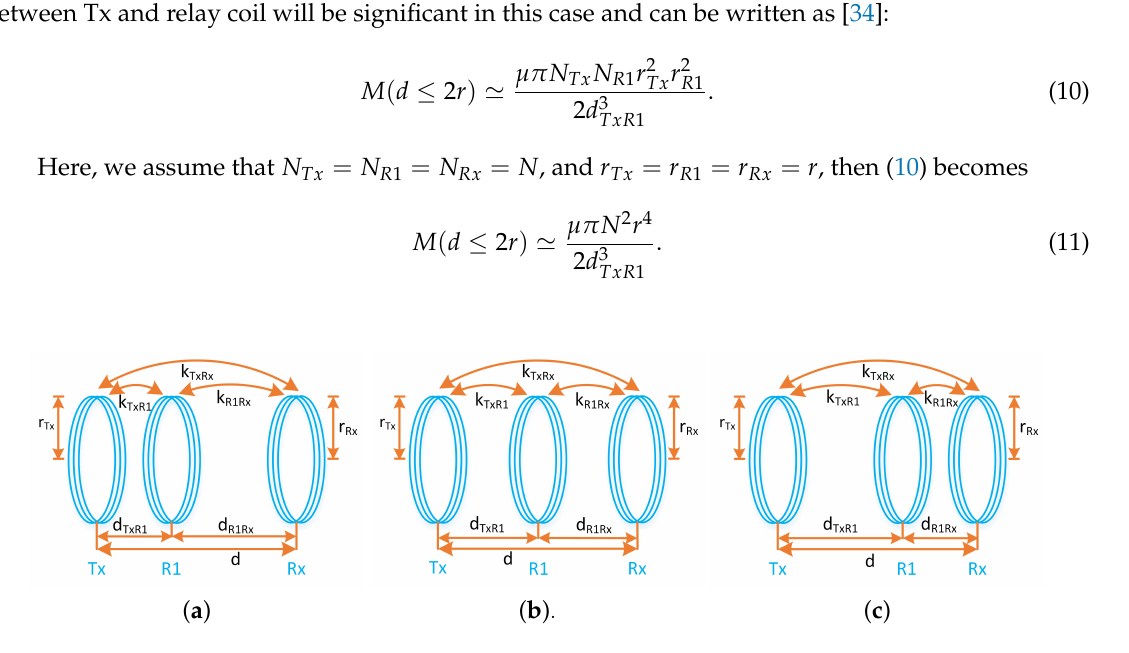
Figure 3. Three different regions for optimal relay position, ( a ) region 1, ( b ) region 2, and ( c ) region